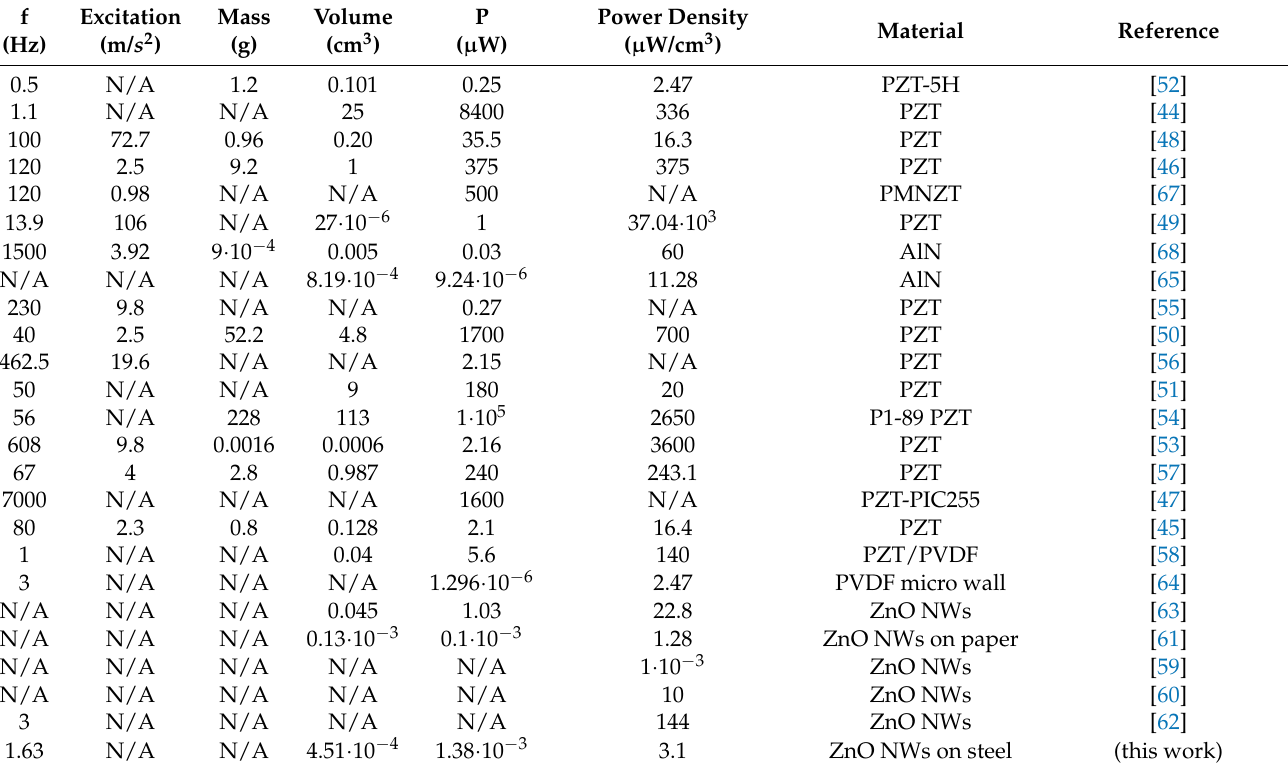
Table 1. Summary of reported piezoelectric harvesters and their